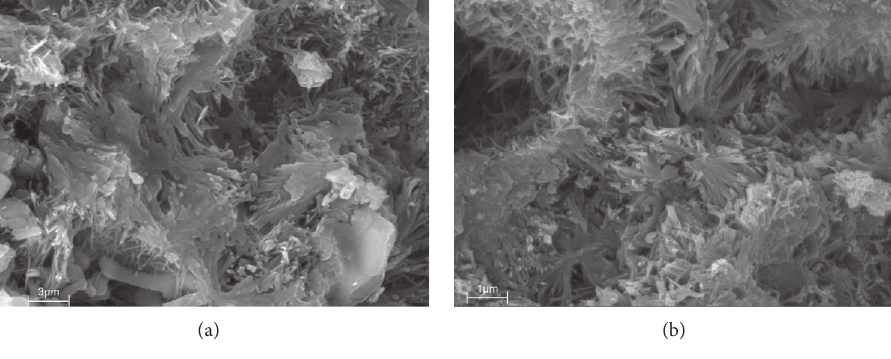
Figure 8: Micromorphology of cement sample R0.